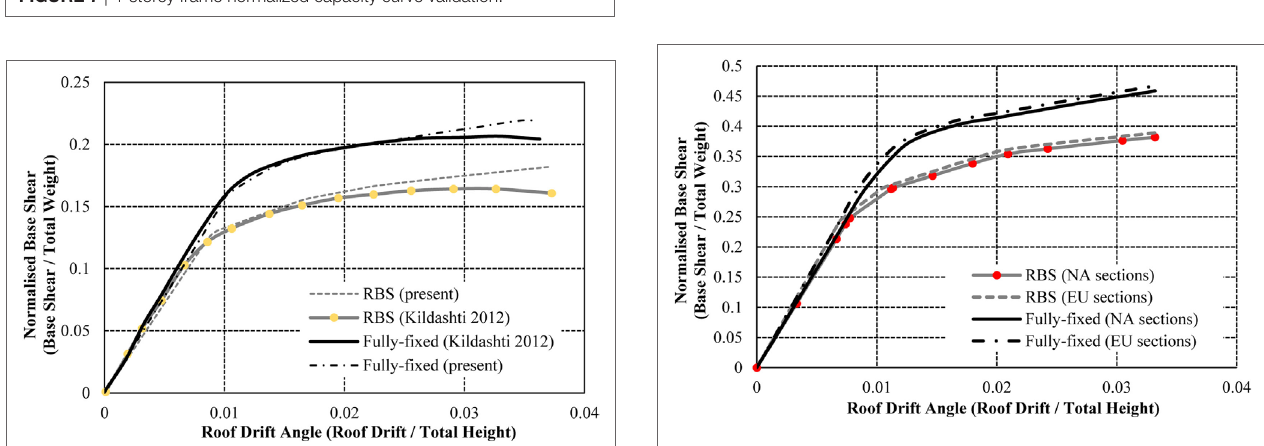
Figure 8 | 8-storey frame normalized capacity curve validation.